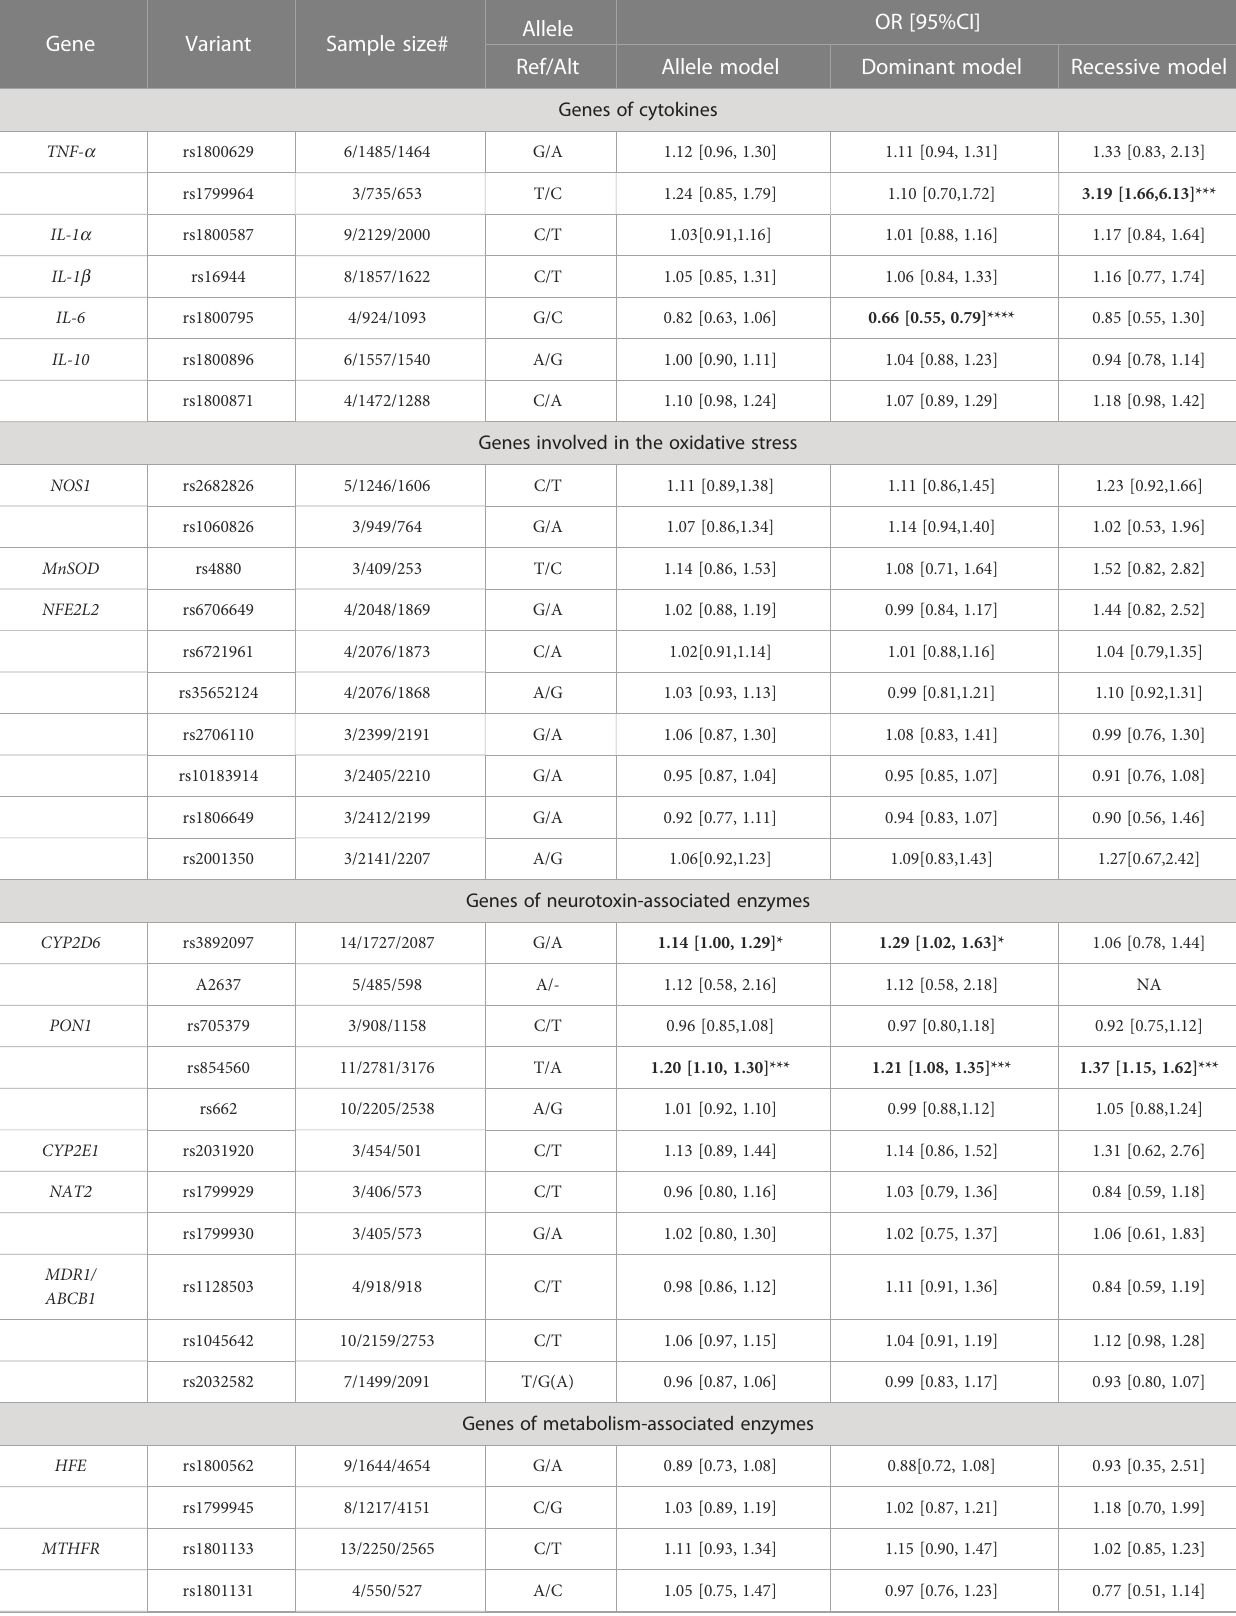
TABLE 3 The results of quantitative analysis for the association between included variants and the risk of PD in different